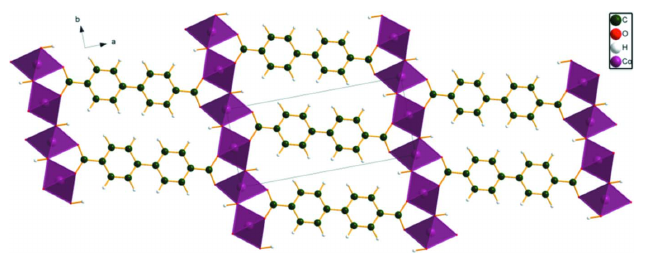
Figure 8 Crystal structure of Co 2 (BPDC)(OH) 2 , viewed down the c -axis. Image generated using DIAMOND (Crystal Impact, 2022).